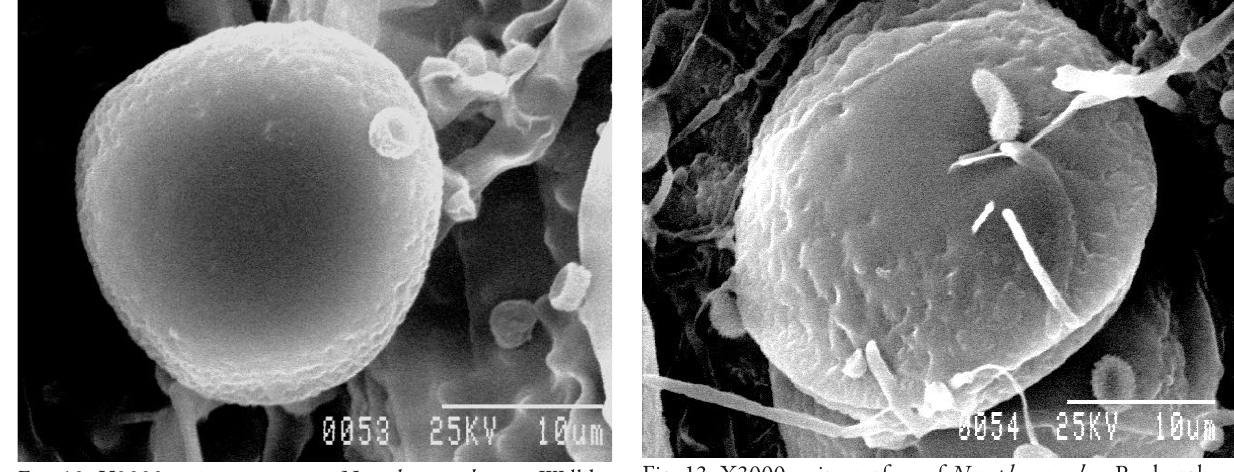
Fig. 10. X3000, exine pattern in Nymphaea pubescens Willde- now